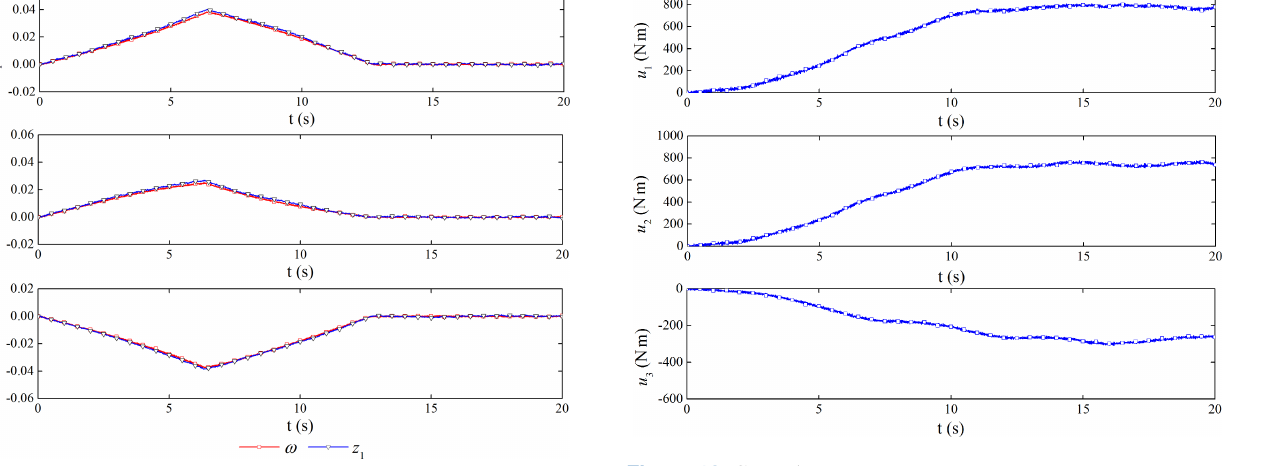
Figure 17. Angular-velocity estimation.